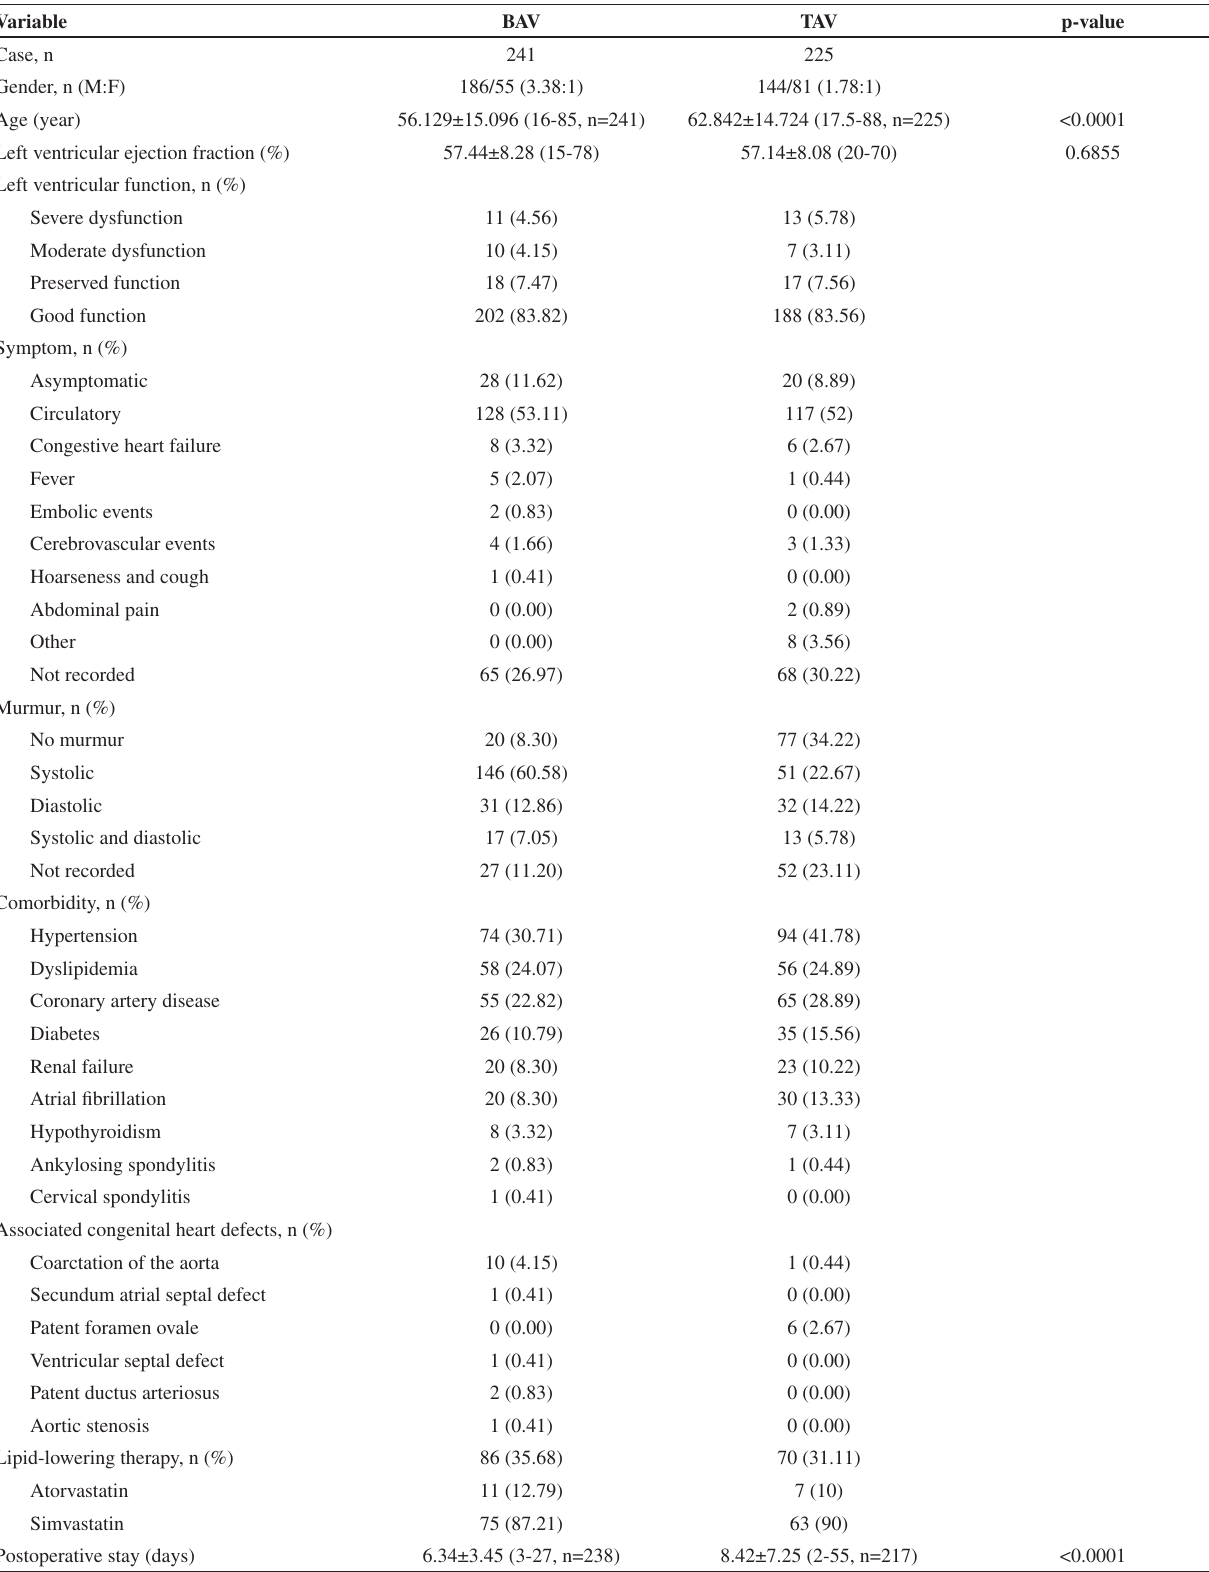
Table 1 - Clinical characteristics of included